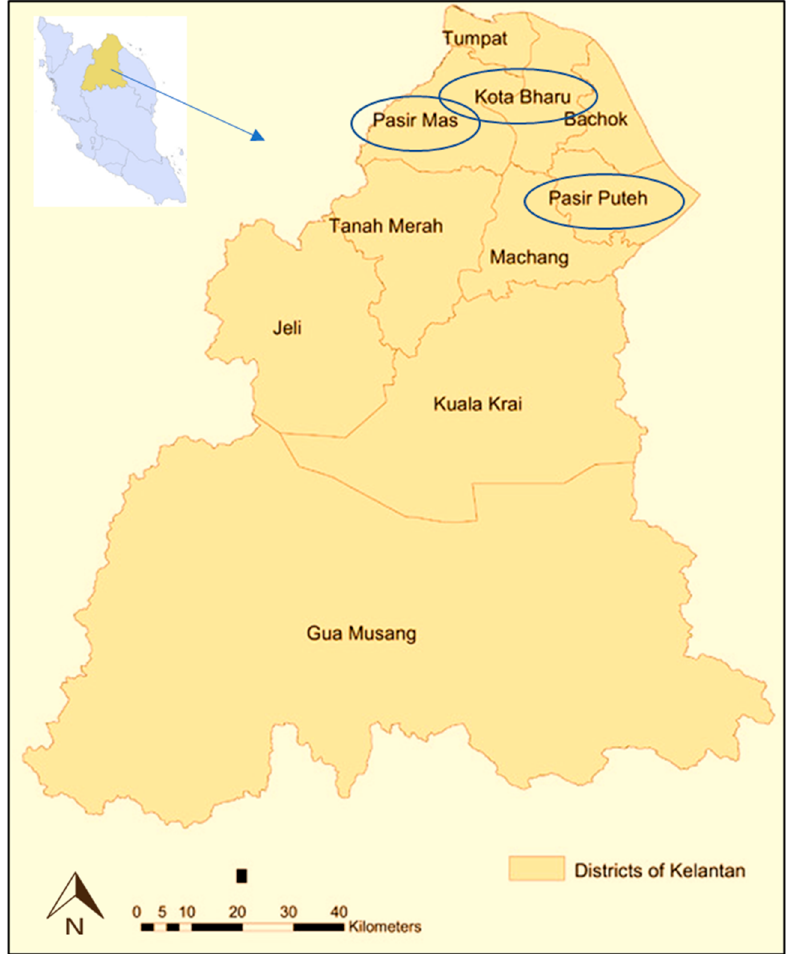
Figure 1. Map showing the sampling areas at Kelantan, Malaysia Eastern region.